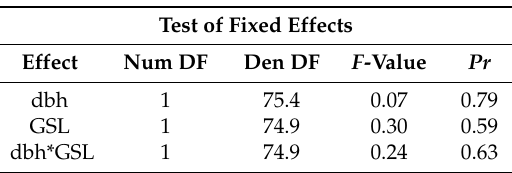
Table A3. ANOVA table for the relationship between diameter at breast height (dbh) and the number of emerging mountain pine